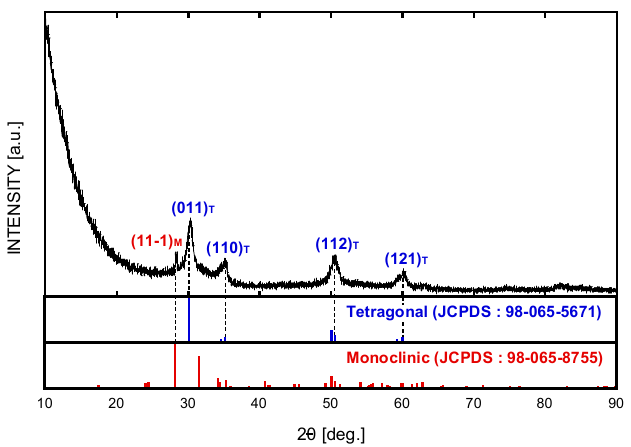
Figure 5. X-ray diffraction acquired from the ALD-based ZrO 2 thin films. Deposition temperature: 150 °C, CMEN-Zr pulse time: 2.5 s, O 2 plasma pulse time: 9 s, PEALD cycle: 300 cycles (~27 nm), substrate: P-type silicon.